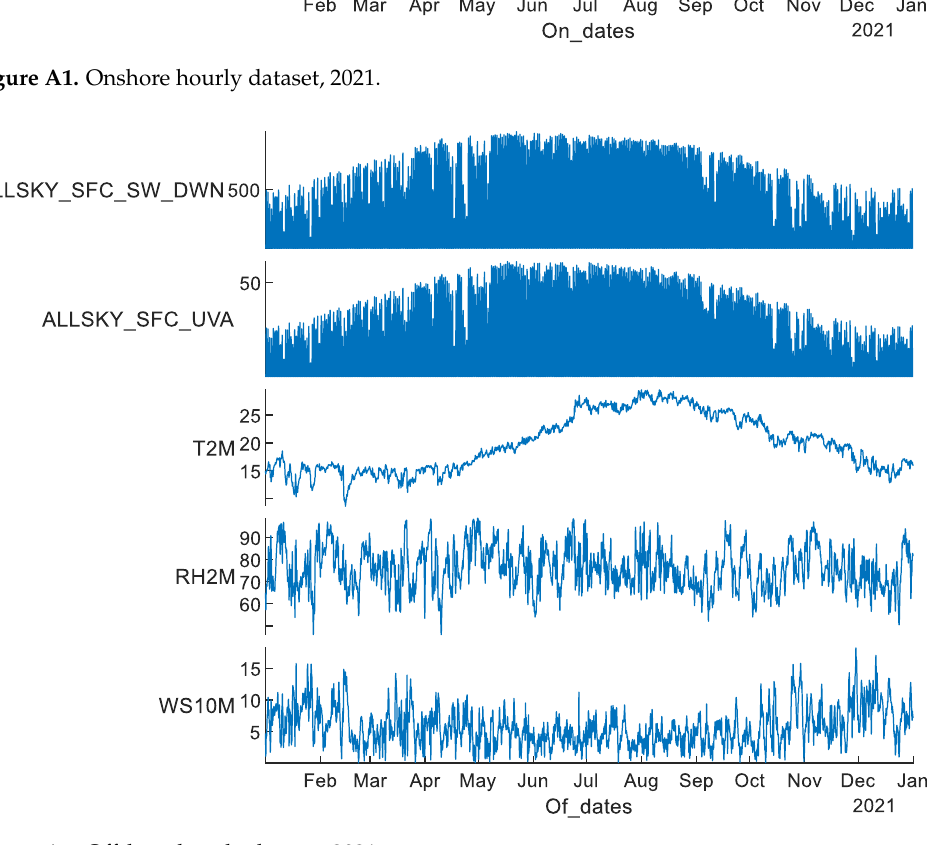
Figure A2. Offshore hourly dataset, 2021.